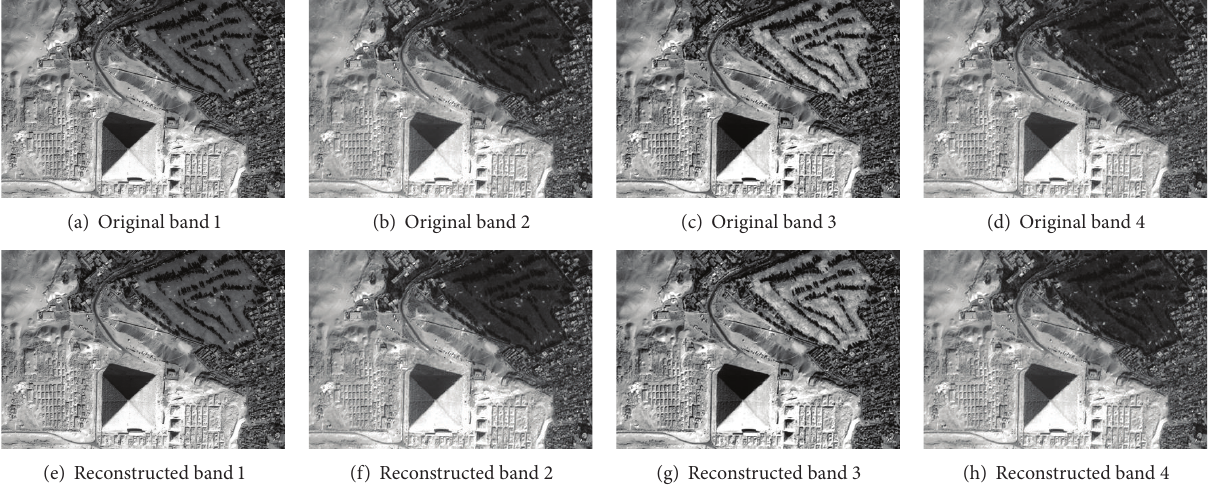
Figure 6: Encoding multiband images at 2.0